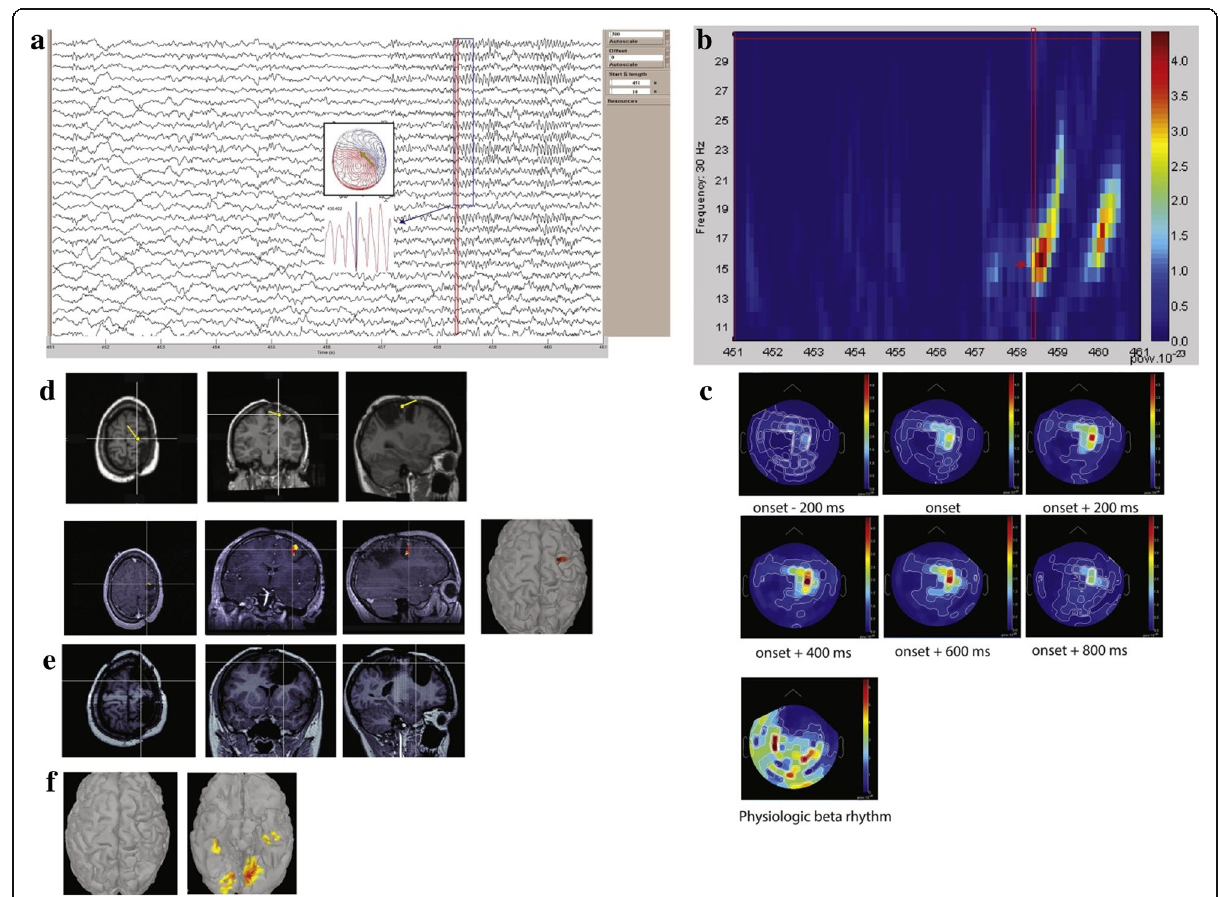
Fig. 4 Ictal MEG localization, comparison of minimum norm estimation (MNE) with FCD [28]. a MEG at time of seizure onset (arrow). b Morlet wave transformation. c Mapping of current density of the narrow band identified in b . d Localization in the precentral gyrus by equivalent current dipole (ECD) analysis (upper row), and localization in the anterior edge of the prior resection (21.8 mm to ECD) by L2 MNE solution (lower row). e Postsurgical resection of the area delineated by L2-MNE narrow band. The MNE solution was in the resection cavity. f L2-MNE solution, the ECD localization was 21.8 mm more posterior. Only the MNE localization was within the resection